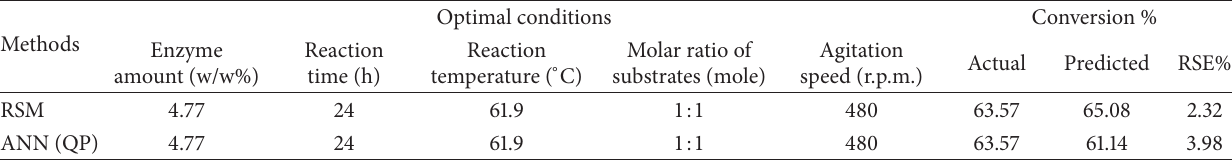
Table 6: Optimum conditions derived by RSM for synthesis of TEA-based